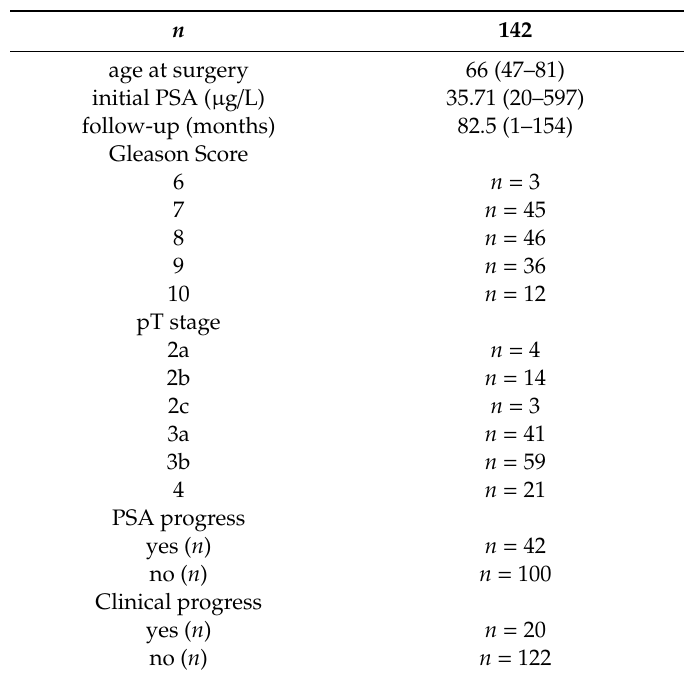
Table 1. Characteristics of our high-risk prostate cancer (PCa)